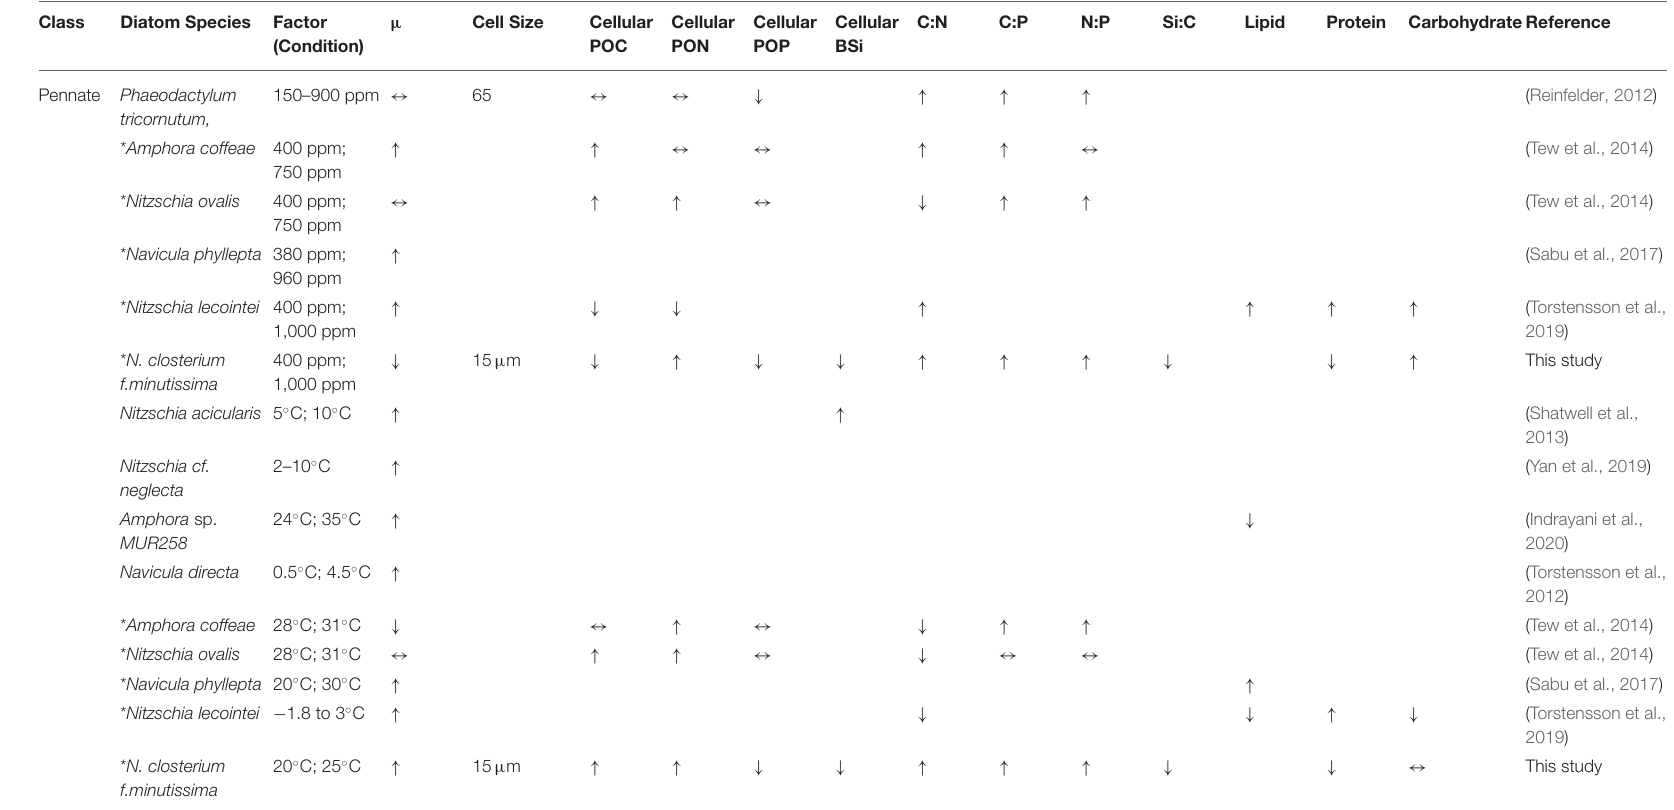
“ ↑ ”Represents increase, “ ↓ ” represents decrease, and “ ↔ ” represents no significant change. * Represents the combined effects of ocean warming and acidification on the centric and pennate diatom’s